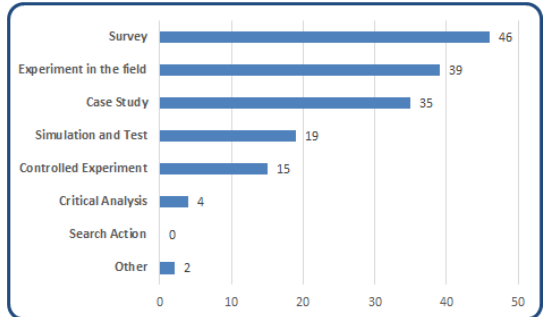
Figure 6. Results of RQ4: Type of empirical investigation.